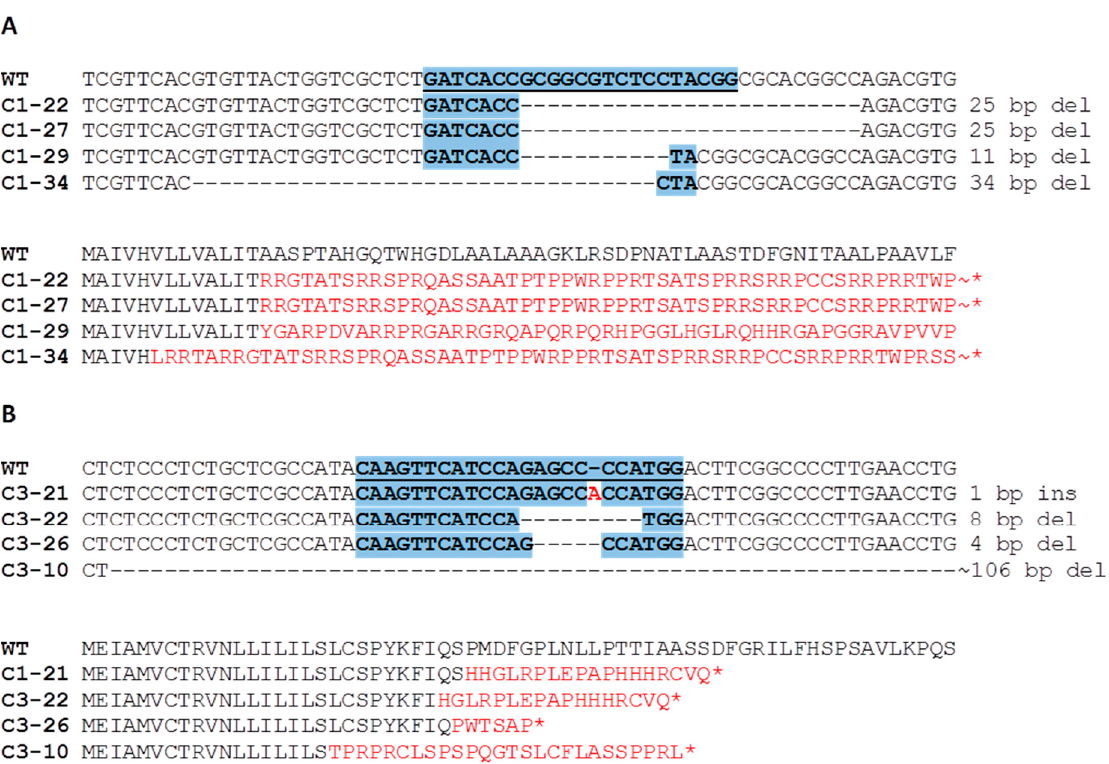
Figure 1. Types of mutations detected in the HvCKX1 ( A ) and HvCKX3 ( B ) genes of T 1 lines and changes in the predicted amino acid sequences encoded by mutant alleles. Target sequences of the RNA-guided Cas9 nuclease are shaded in blue. Amino acid sequences resulting from the frameshift are marked in red.